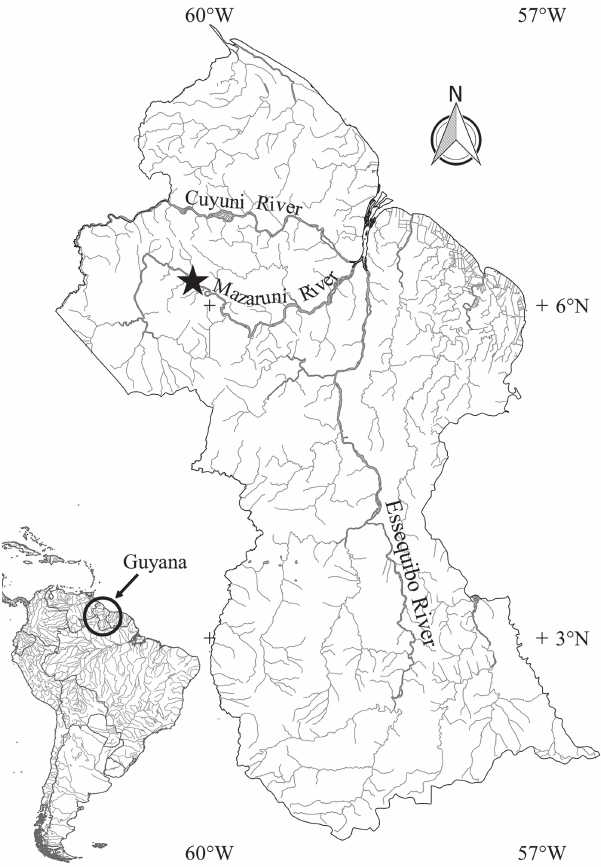
Fig. 4. Distribution map of Myloplus taphorni in middle Mazaruni River indicated by the black star.